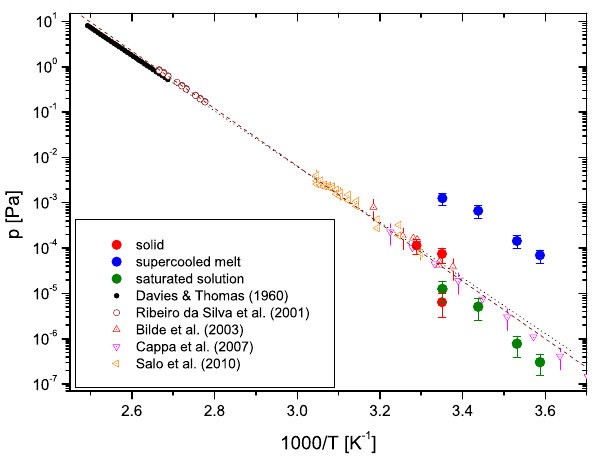
Fig. 10. Succinic acid vapor pressure versus temperature. Solid symbols: this work; Open symbols: literature data as indicated in the figure; Dotted black line: extrapolation of high temper- ature data Davies and Thomas (1960) to ambient temperatures, dashed wine line: extrapolation of high temperature data Ribeiro da Silva et al. (2001). Note that the two data points of the solid at 1 /T = 3 . 35 × 10 − 3 K − 1 originate from the same particle, but at different times after efflorescence, see Fig. 9 and discussion in the